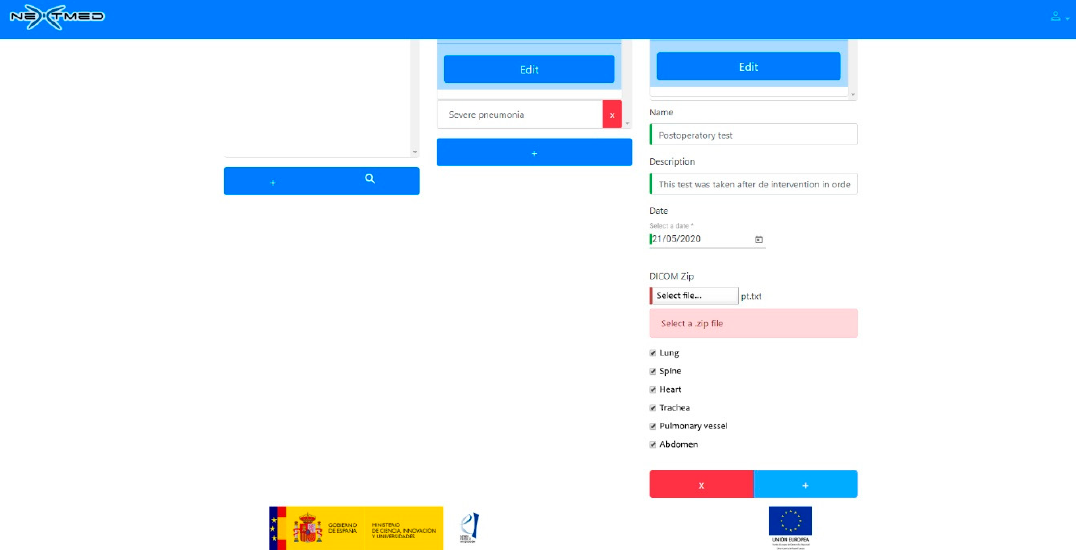
Figure 18. Loading new dicom images to web platform selecting what anatomical regions should be segmented and modeled.